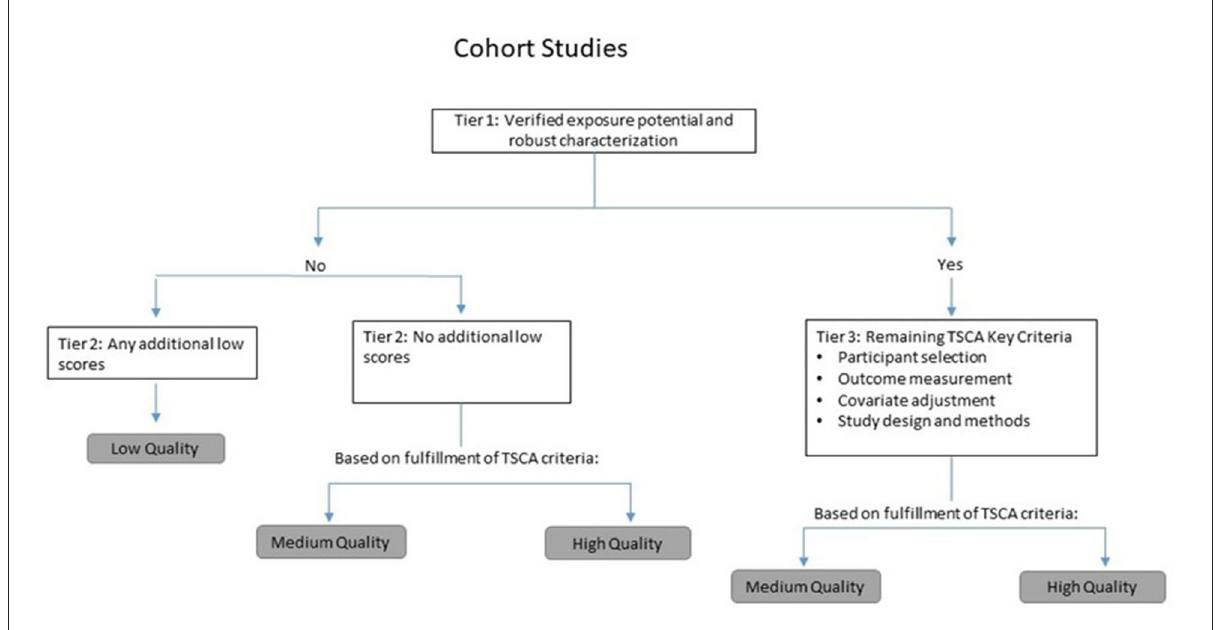
FIGURE1 Tiering approach used in evaluating cohort